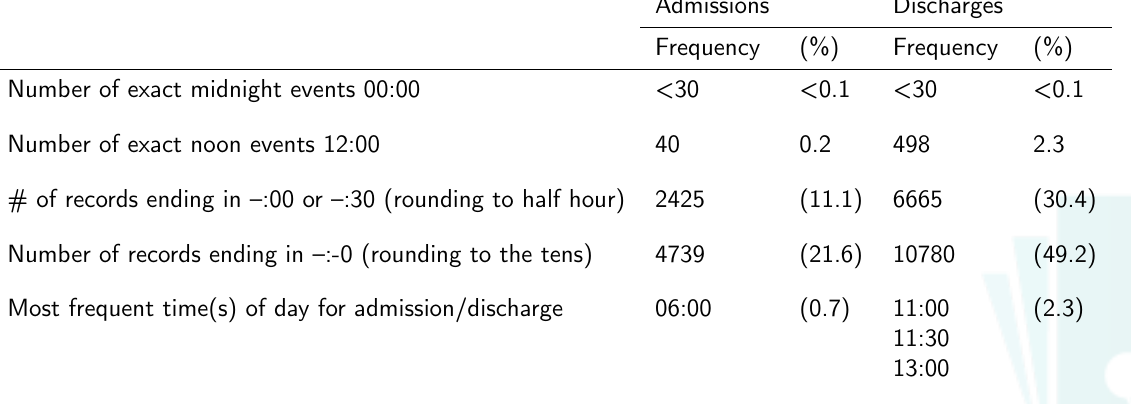
Supplementary Table 2: Descriptive statistics and frequencies of time of day for admission and discharges. (n=15,458